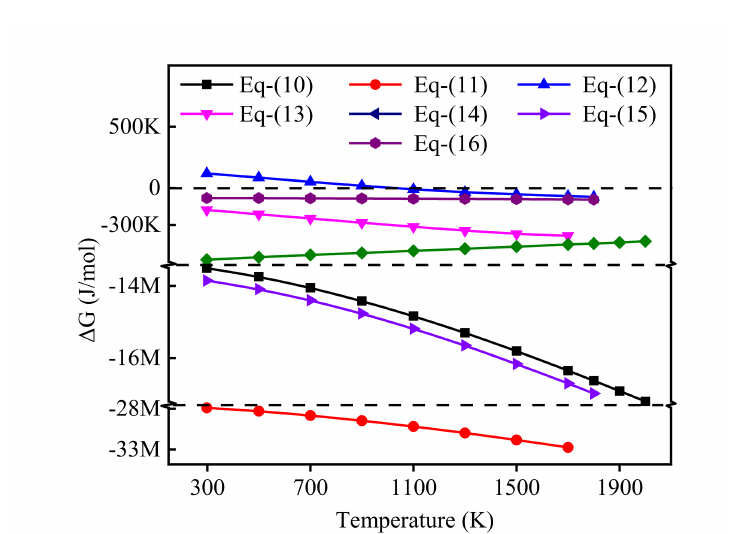
Figure 4. Gibbs free energy of Equations